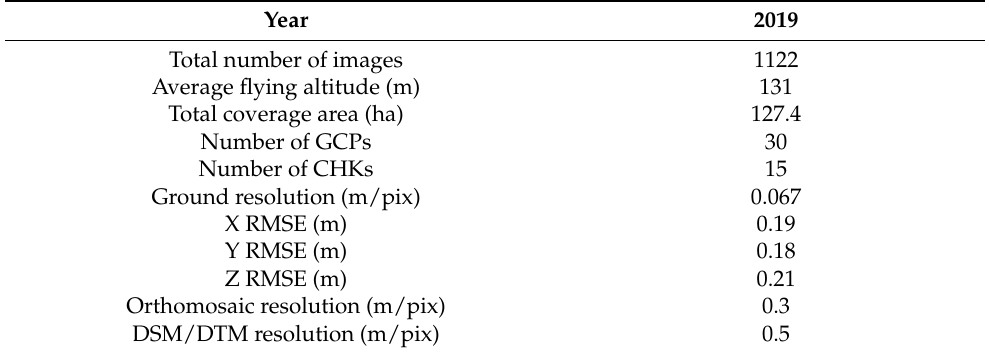
Table 2. Data and accuracy of the UAV surveys and related three-dimensional